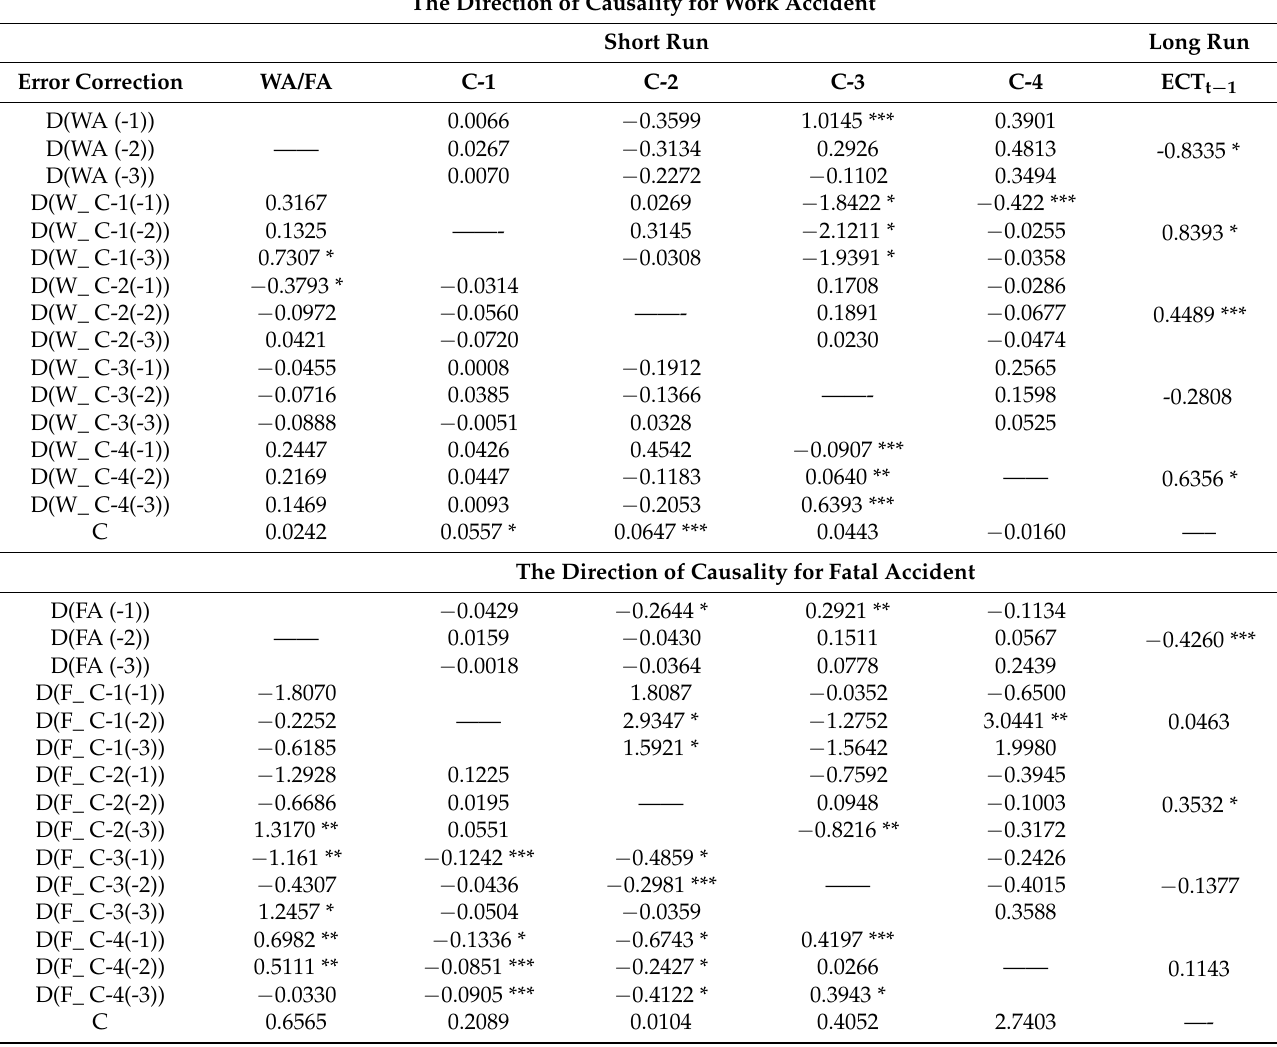
Table 6. Vector error correction estimates